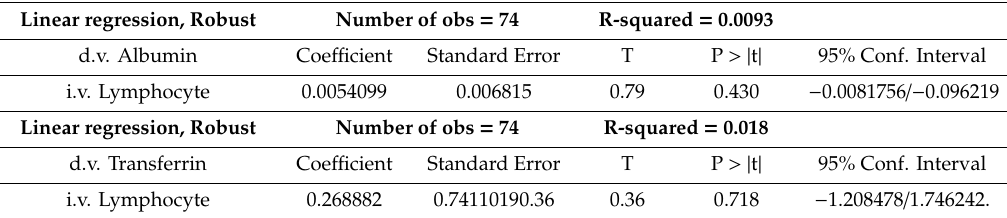
Legend to Table 4. Noteworthy is the lack of prediction of the well-accepted parameters of nutritional status by lymphocyte count, casting some doubts on its validity in exploring the nutritional status alone, but more